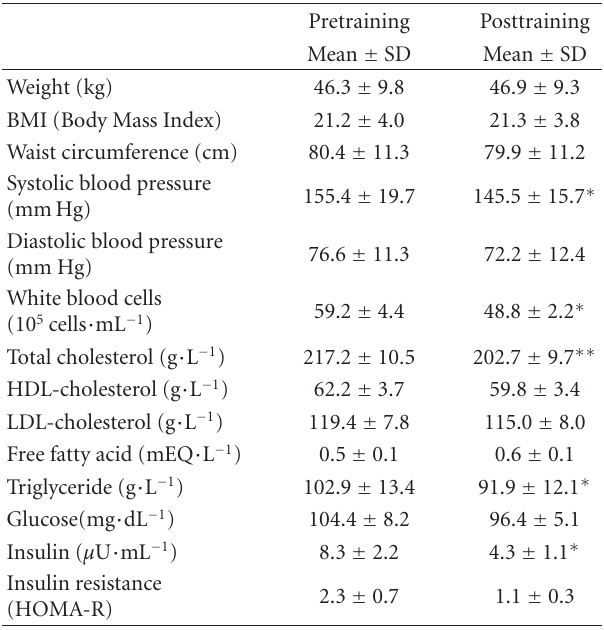
Table 1: Change in anthropometric characteristics and biochemical factors before and after exercise training in elderly women ( n =